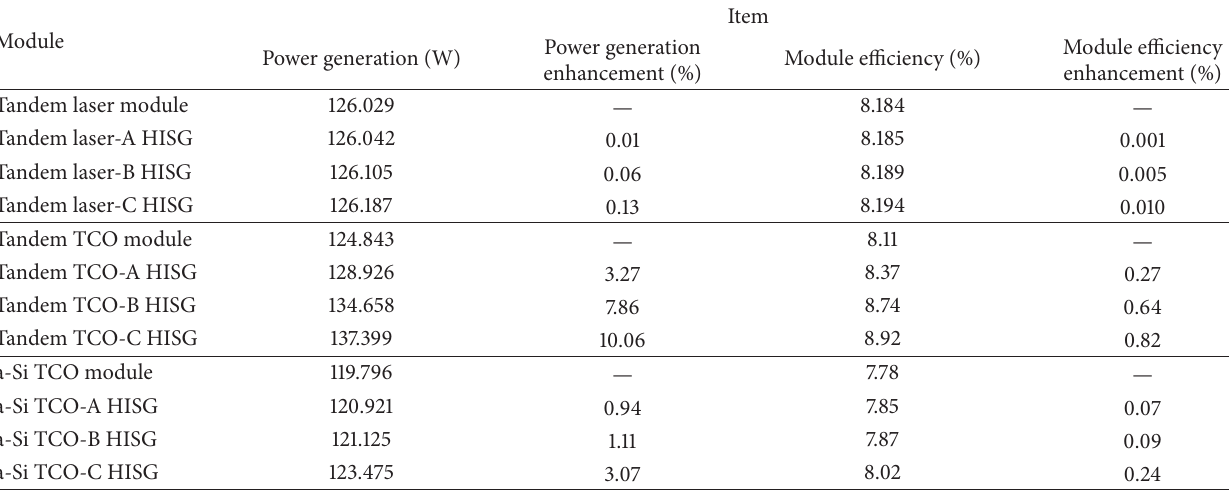
Table 6: Results of power generation gain tests of the semitransparent PV modules and each combination of HISG under STC.